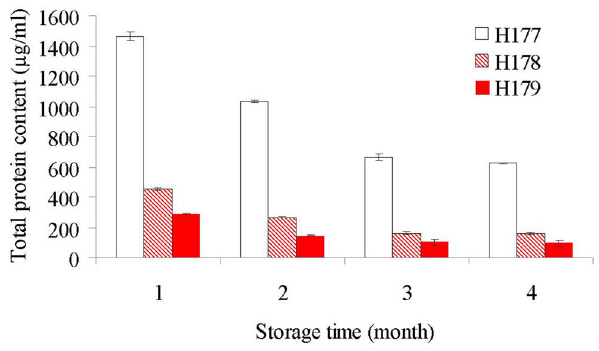
Figure 1. Changes in protein concentrations during the first 3- month storage time of